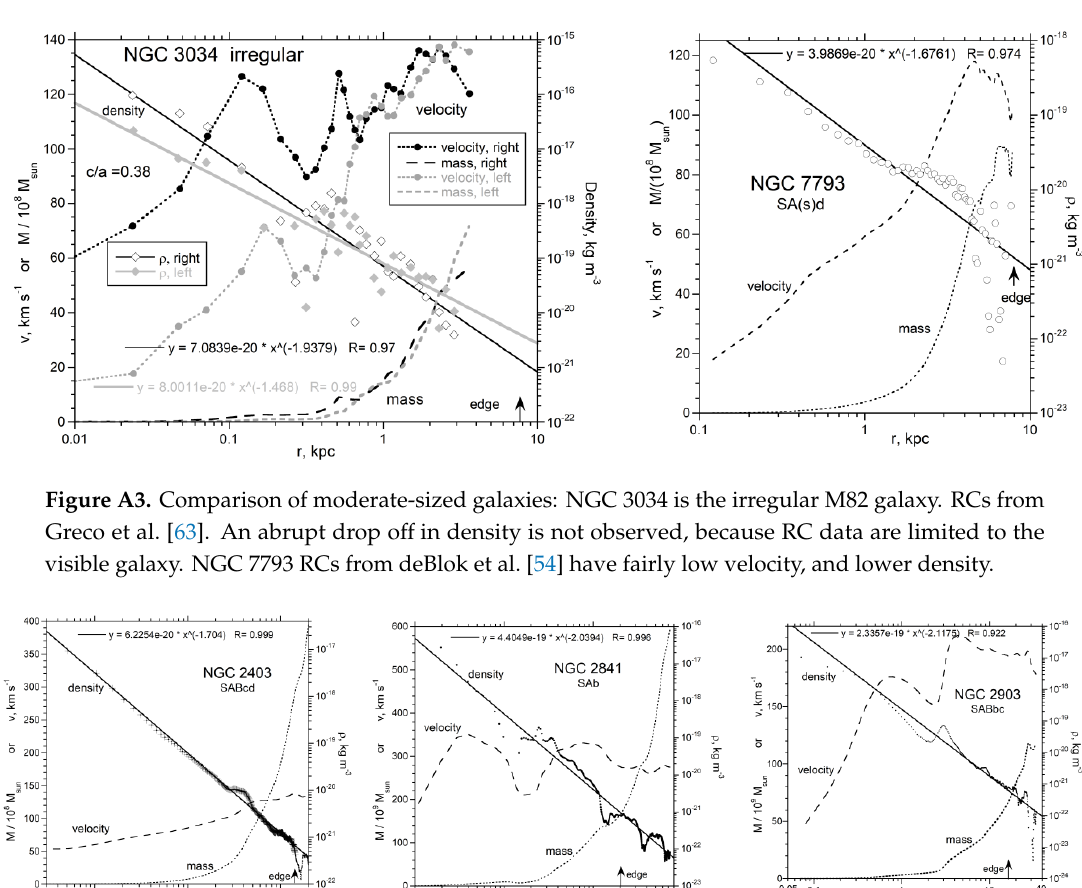
5 of 33 Figure A2. Large spirals: NGC 253 RCs from Sofue et al. [66] and derived M and ρ are colored grey. RCs from Hlavacek-Larrondo et al. [69] are black curves. Although velocity data differ substantially, similar mass and density are obtained near the visible edge. Differences at small r affect the fits to ρ ; NCG 925 has low velocities which produce low density; NGC 2599 RCs from Noordemeer et al. [61].